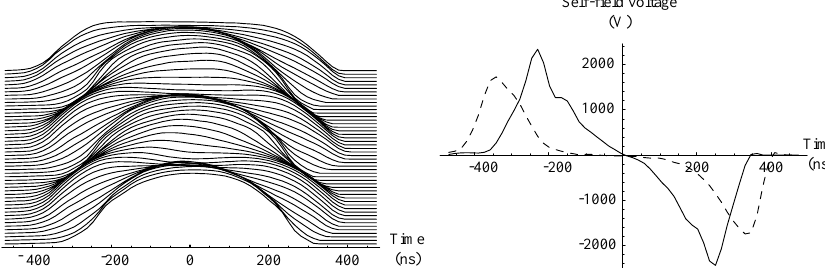
FIG. 1. Left: bunch shape oscillations of 6.5 3 10 12 protons measured after an abrupt reduction in the second-harmonic component of a stationary dual-harmonic bucket at 100 MeV in the CERN PSB. Right: corresponding self-field voltage functions obtained from the mean derivative of the first two (solid line) and last two (dashed line)